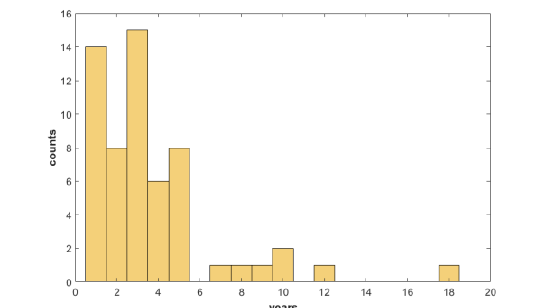
Figure 6 Experience in UAV operation in number of years of people with an own UAV sensing system.